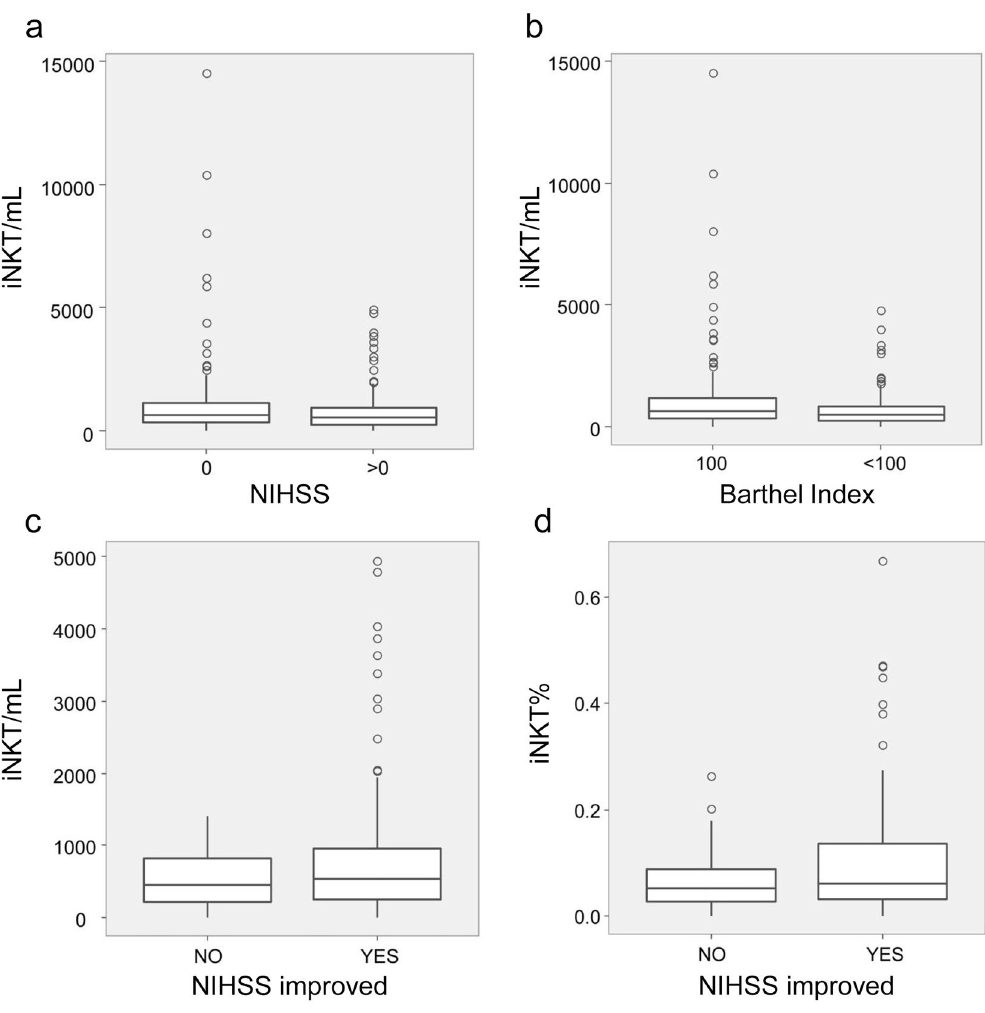
Figure 1. Peripheral blood iNKT cells are decreased in patients with impaired neurological function, activity of daily living and unimproved NIHSS scores. The boxplots of the peripheral blood iNKT cells counts in patients divided by NIHSS score ( a ) or Barthel index ( b ). The boxplots of the peripheral blood iNKT cell counts ( c ) and cell percentages ( d ) in patients grouped according to NIHSS scores at discharge focusing whether their scores were improved or not. NIHSS, National Institutes of Health Stroke